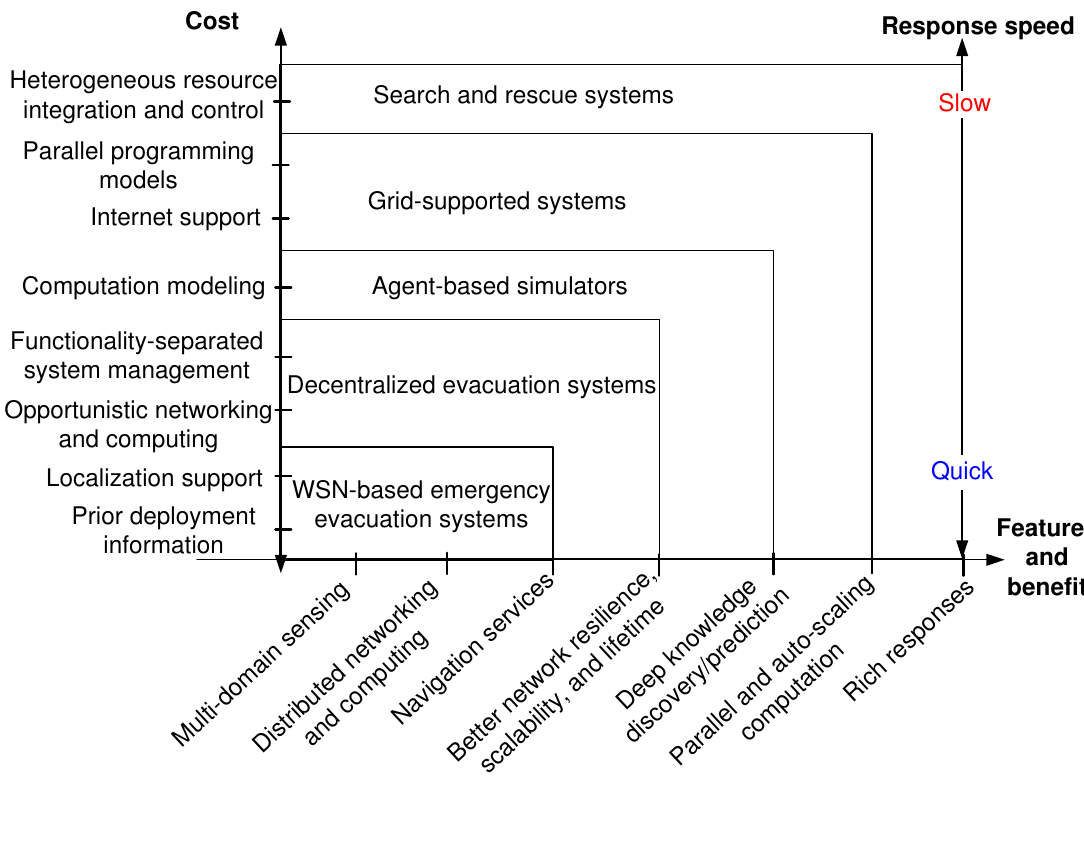
Table 2. A comparison of indoor and outdoor evacuation and rescue